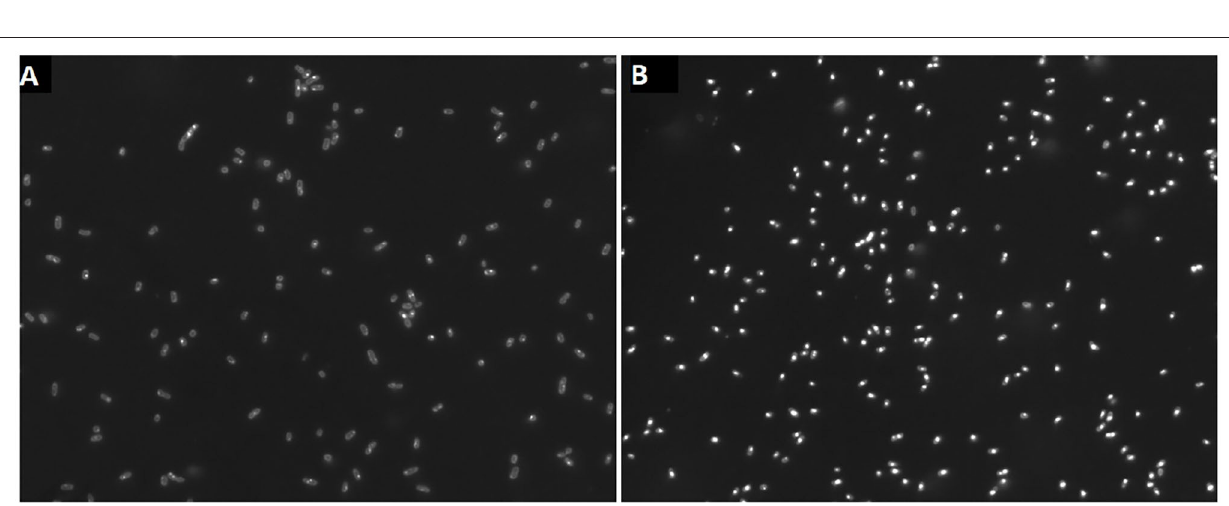
mmsA1 (HELO_1515), mmsB (HELO_2425), and HELO_2317 probably involved in the metabolism of aliphatic amino